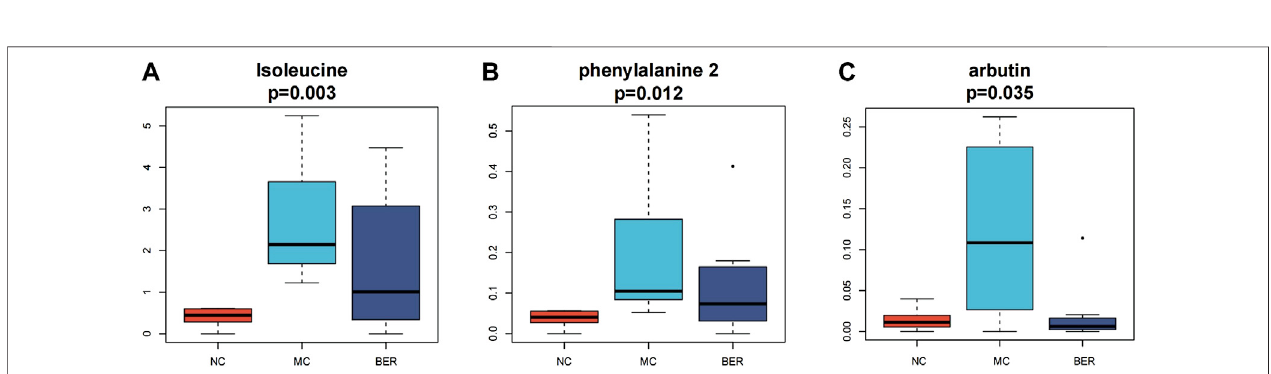
S2I ), PLS-DA ( Supplementary Figure S2J ) and OPLS-DA ( Supplementary Figure S2K ) were performed on faecal metabolites in the MC and BER groups. The compositional changes in faecal metabolites in the mice involved 50 signi fi cantly different analytes between the two group ( Supplementary Figure S2L ).